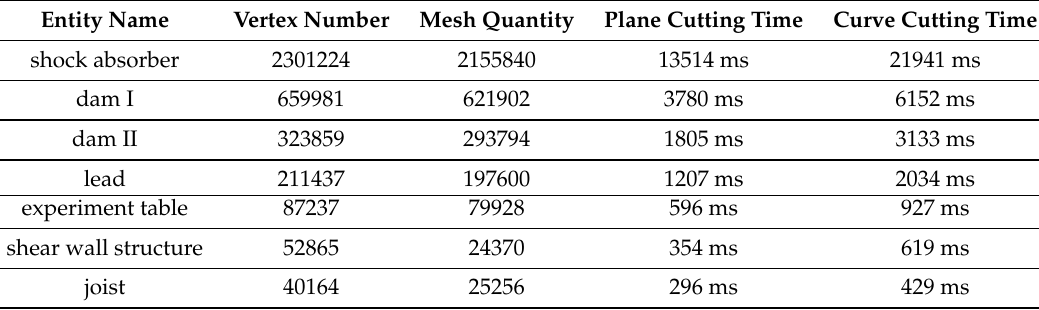
Table 1. Cutting time for different